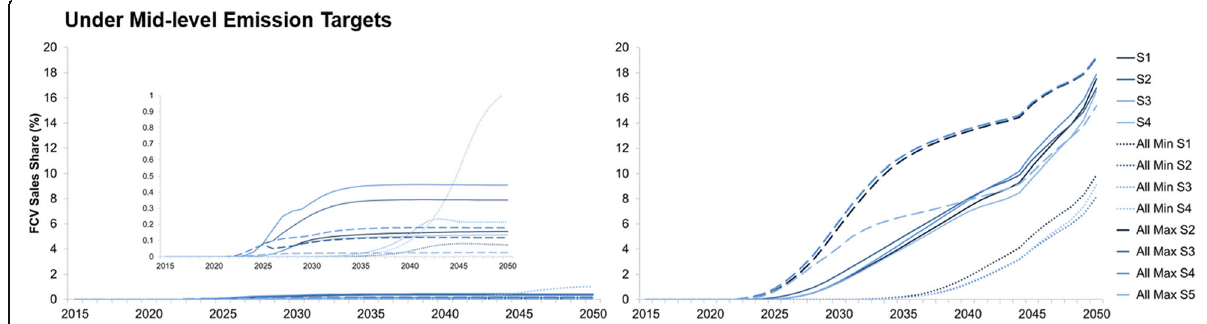
Fig. 8 FCV sales shares under Base and Mid-level emission targets and various subsidy regimes (inset – Base on smaller scale)